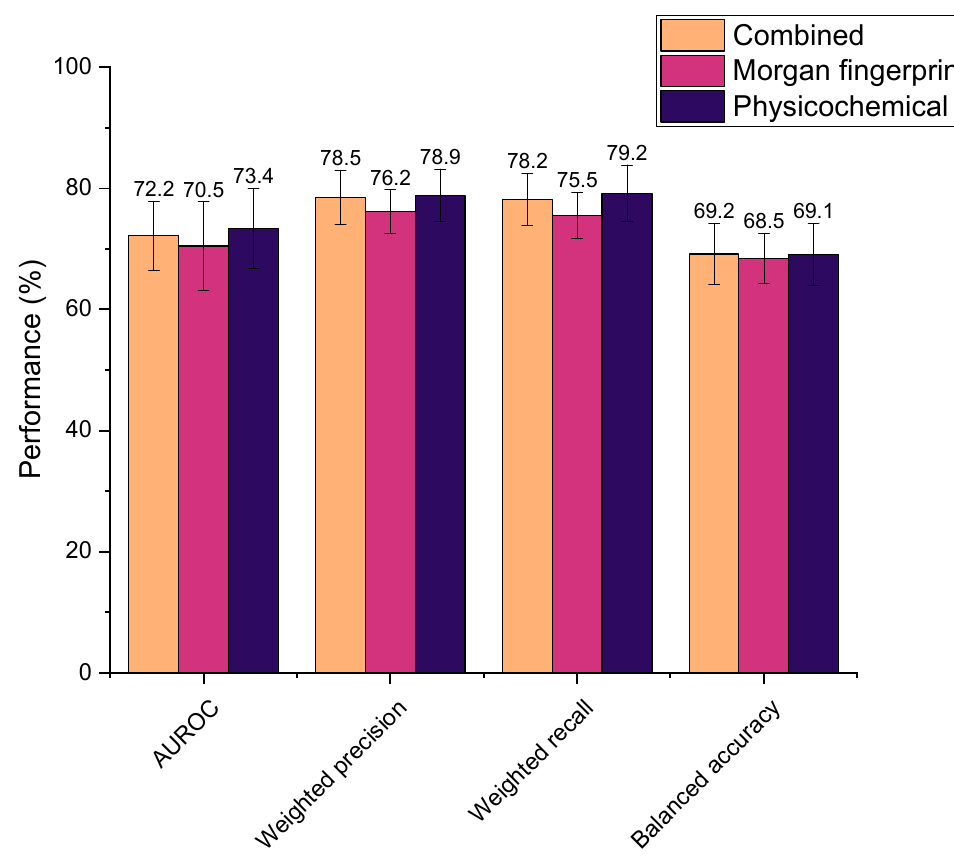
Figure 4. Performance of extra trees machine learning models in predicting drugs’ microbial depletion status. Bar colours indicate the features used to describe drugs in the training dataset. Combined: both Morgan fingerprints (radius 2, 1024 bits) and 200 physicochemical parameters (from Python’s RDkit).